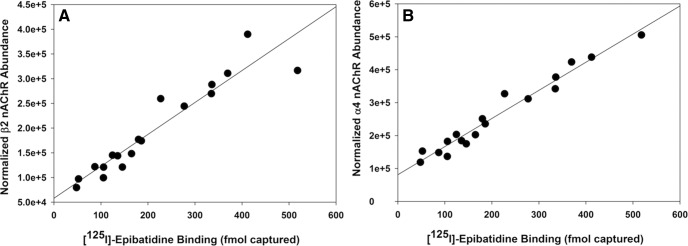
[125I]-epibatidine binding to α4β2*-nAChRs in human temporal cortex homogenates correlates well with β2-nAChR (A) and α4-nAChR (B) subunit abundance estimated by normalized unique peptide abundance determined by peptide LC-MS/MS.